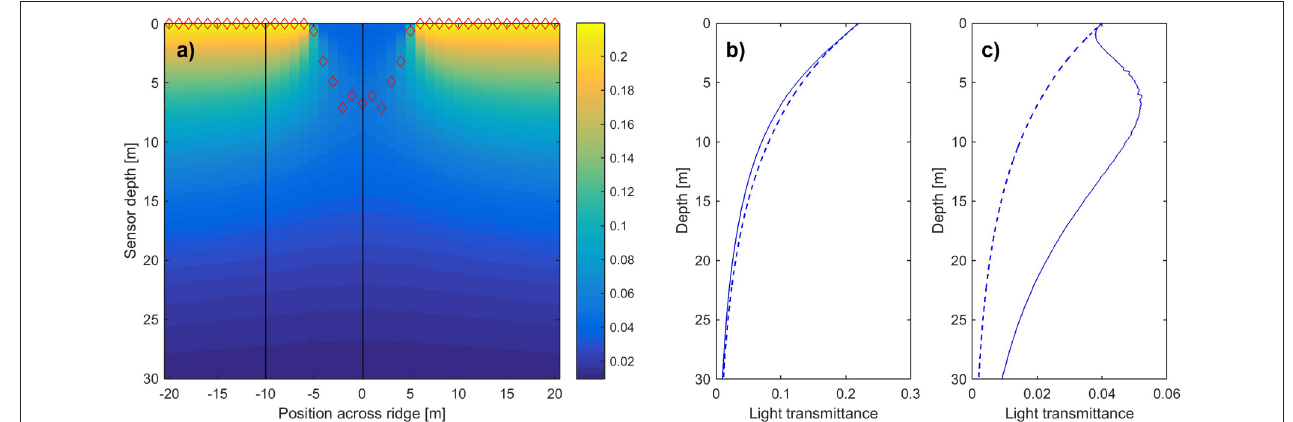
FIGURE 6 | (A) Vertical depth profiles across a linear dark patch. Red diamonds mark the location of the maximal irradiance. (B) Vertical irradiance profile for the position shown by the black lines in a within the bright patch (C) and in the middle under the dark patch. Solid blue lines show the calculated irradiance profile while dashed lines are given by a one dimensional exponential decay model.